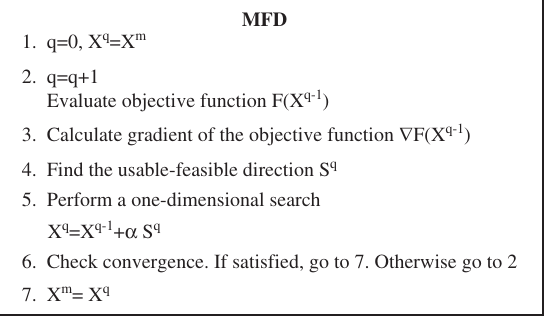
Figure 1 Flow chart of the MFD